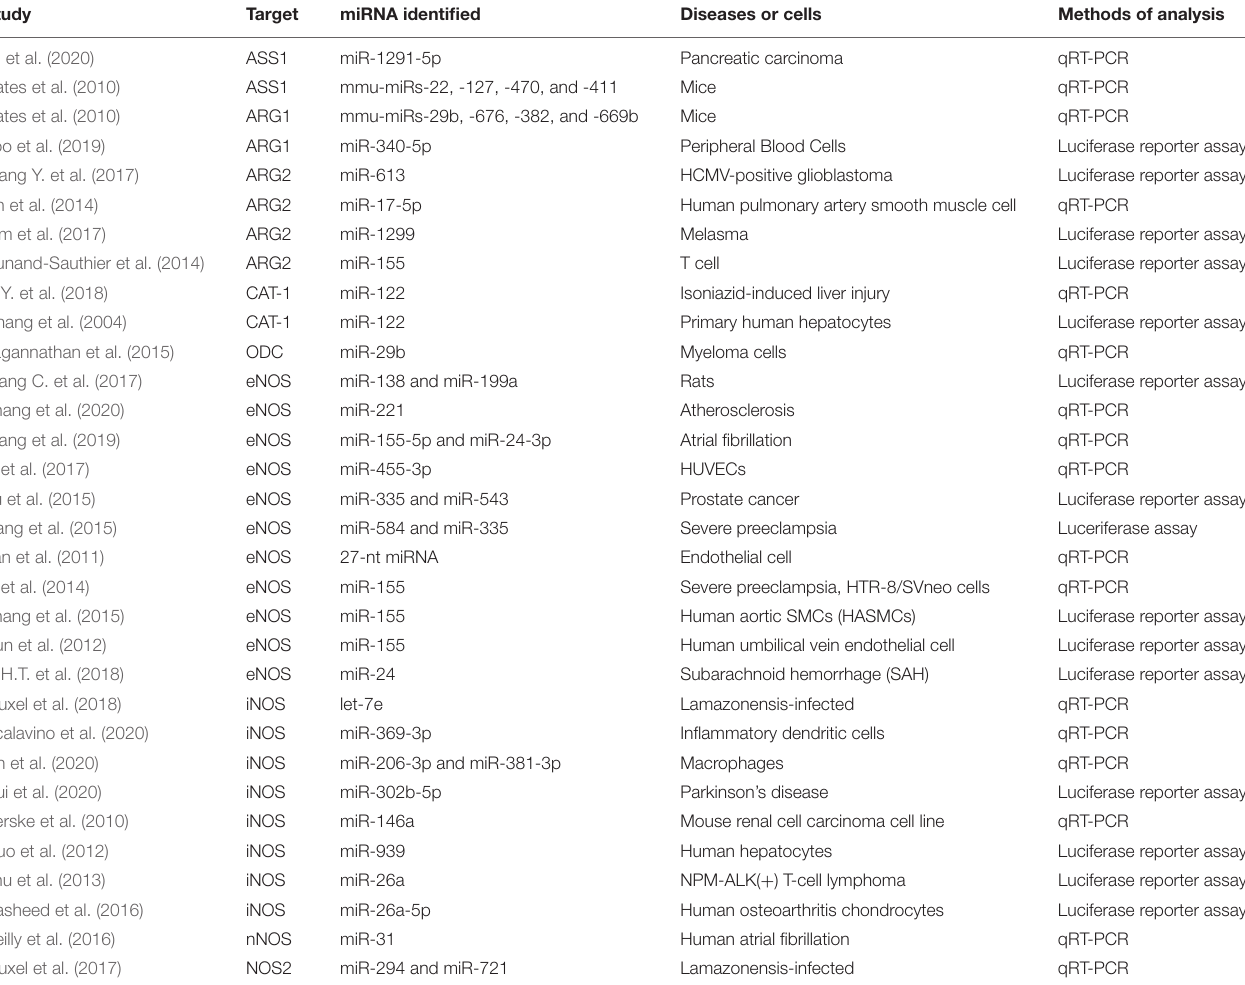
TABLE 1 | miRNAs target to arginine